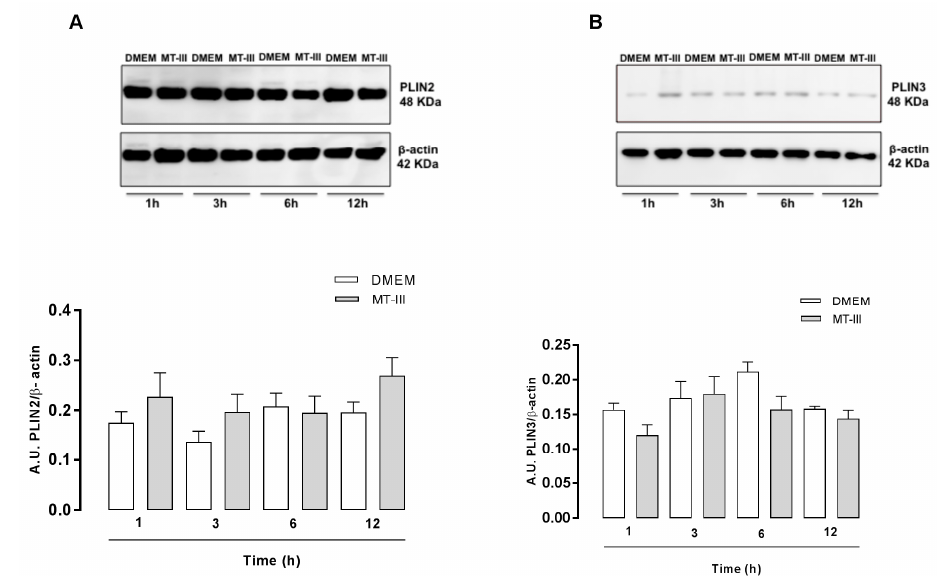
Figure 3. MT-III does not affect PLIN2 or PLIN3 protein expression in VSMCs. VSMCs (5 × 10 4 cells/well) were incubated with DMEM (control) or MT-III (0.4 µM) for 1, 3, 6, and 12 h. Western blot analysis of PLIN2 ( A ) and PLIN3 ( B ) and β -actin (loading control) of the VSMC extracts and the densitometric analysis (in arbitrary units - A.U.) of PLIN2 and PLIN3 expression normalized to β -actin. The results are expressed as the mean ± SEM for three independent experiments ( n = 9) (ANOVA).